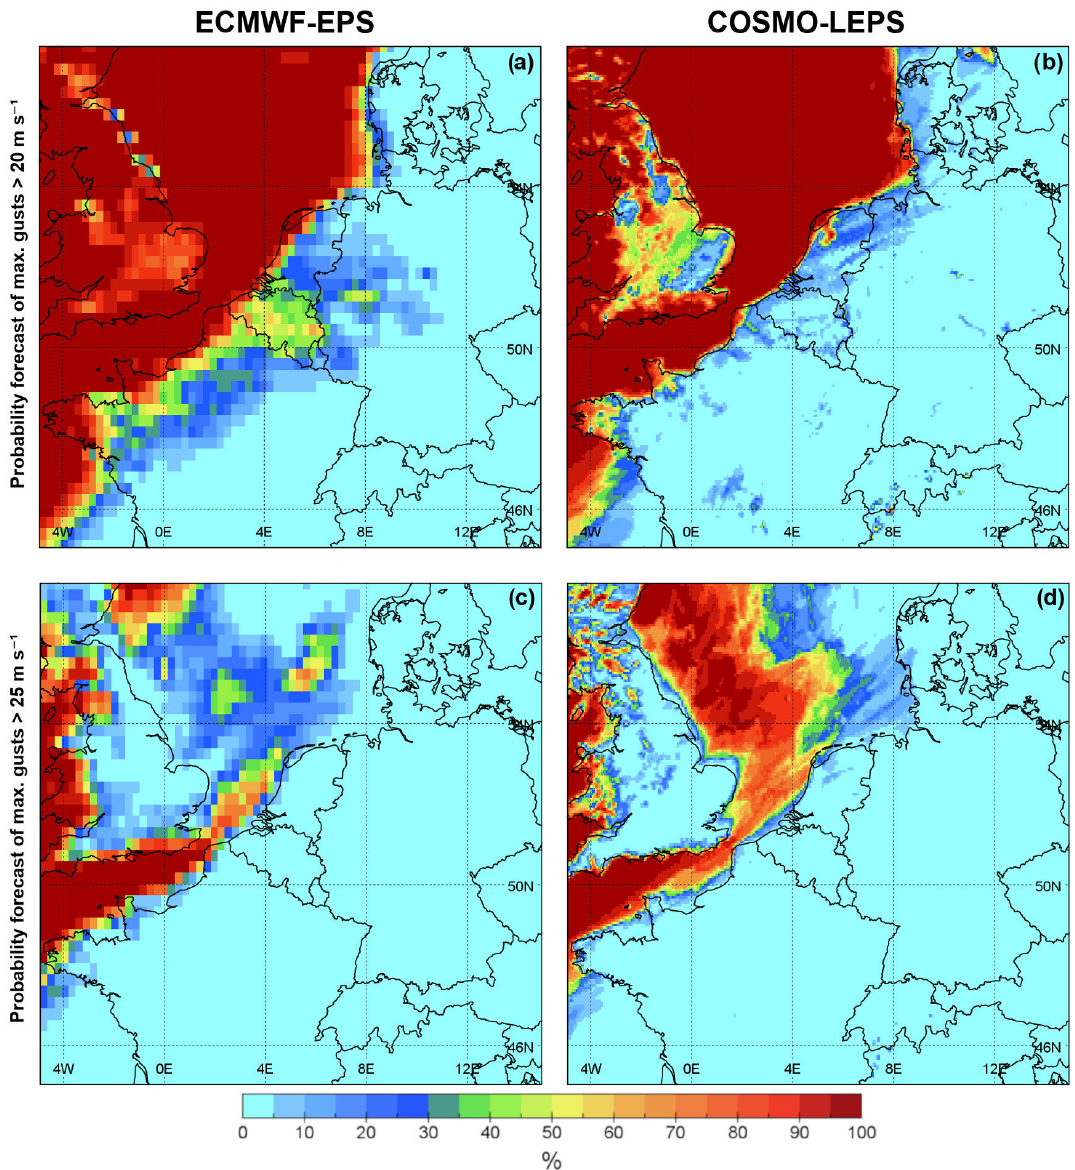
Figure 7. Event probability forecast valid for 00:00UTC on 4 January 2014 by the 00:00UTC run of (a, c) ECMWF-EPS and (b, d) COSMO-LEPS on 3 January 2014 in terms of (a, b) maximum 10ma.g.l. wind gusts exceeding 20ms − 1 within 24h and (c, d) maximum 10ma.g.l. wind gusts exceeding 25ms − 1 within